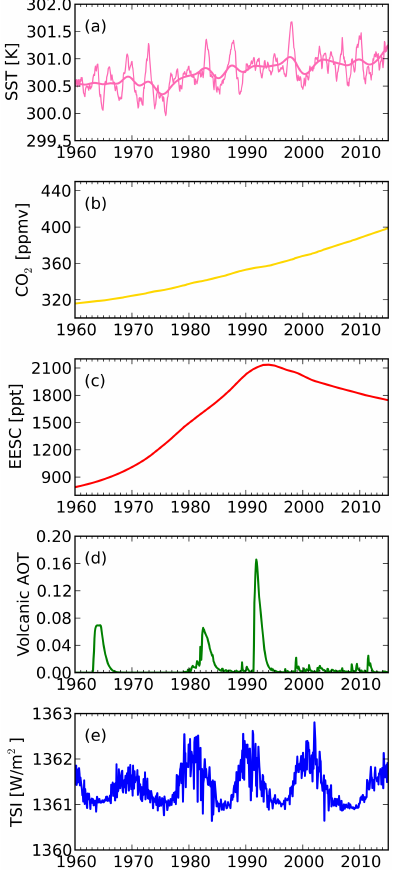
Figure 1. Forcing applied in the simulations. (a) 10 ◦ S–10 ◦ N aver- age sea surface temperatures, with a smoothed version of the curve bolded; (b) atmospheric concentrations of CO 2 following RCP4.5; (c) equivalent effective stratospheric chlorine (EESC; Newman et al., 2007, Eq. 1 with a = 1 and α for Br y = 60, and using 3- year mean age); (d) ensemble mean of the aerosol optical thickness from explosive volcanic eruptions, resulting from prescribed injec- tions of volcanic SO 2 ; (e) total solar irradiance.